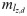
An illustration of the main three input parameters in predicting the proportion of all aquatic habitats contaminated with PPF.This figure presents combined influence of C
M, mlz,d, and 1/Tlz,d upon the availability of uncontaminated aquatic habitats (1-C
l) to the vector population as a simple exponential decay, so that the increasing threshold values required to achieve specific larval habitat coverage targets can be visualized as a log-linear function of their product.